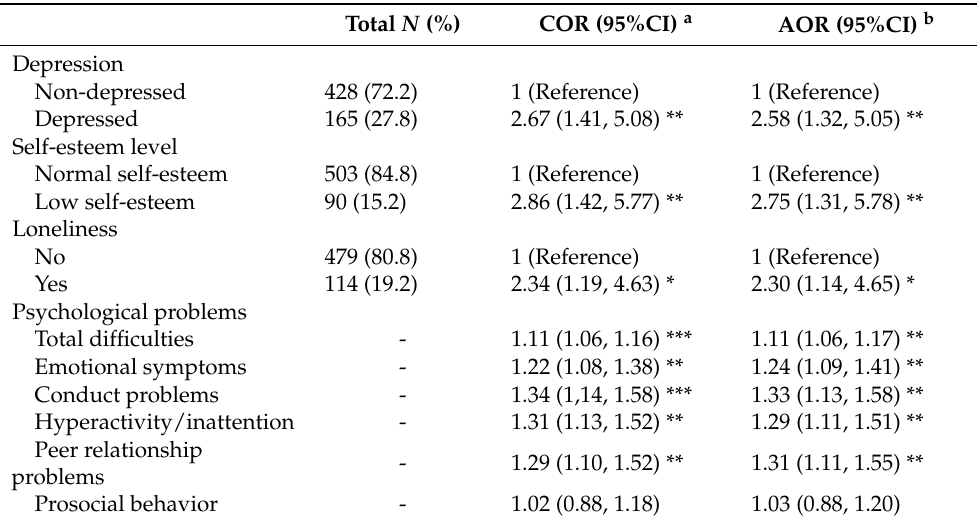
Table 2. Psychosocial correlations of food addiction.